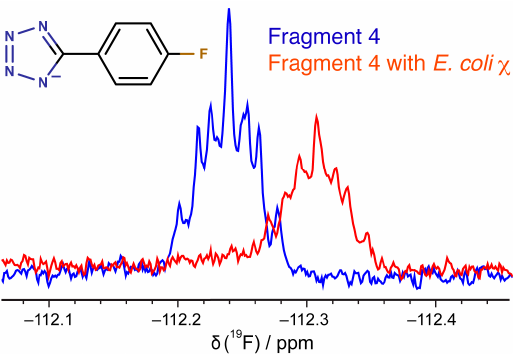
Figure 9. 1D 19 F-NMR spectra. The blue spectrum is of fragment 4 alone and its spectrum in the presence of E. coli χ is shown in red.